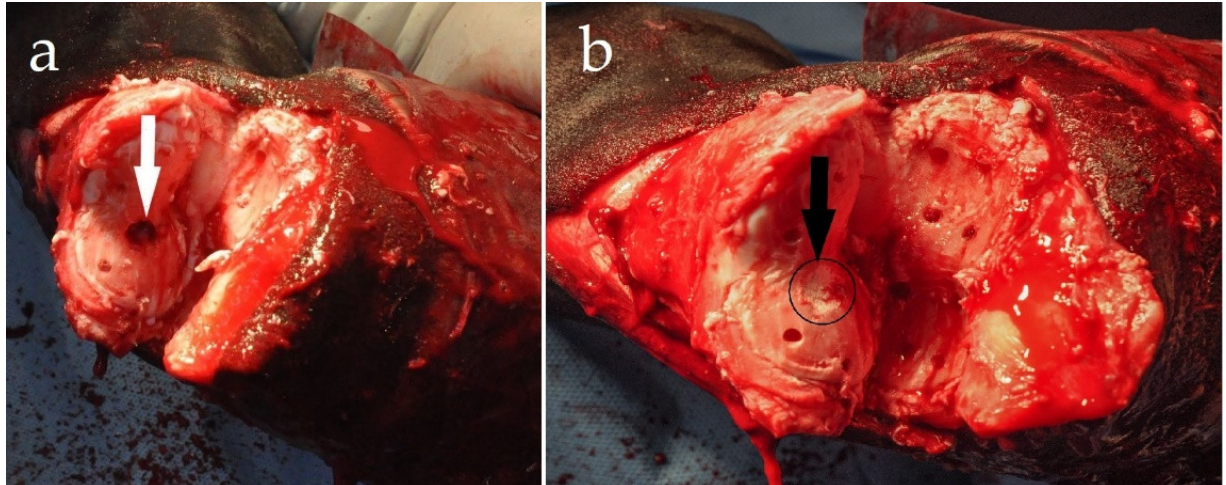
Figure 2. Complete cartilage removal after disarticulation of the proximal interphalangeal joint. ( a ) OCLL in the distal aspect of the proximal phalanx after curettage (white arrow) and ( b ) after packing with CPB (black arrow). Multiple holes were drilled through the subchondral plates (osteostixis) of the proximal and middle phalanges.